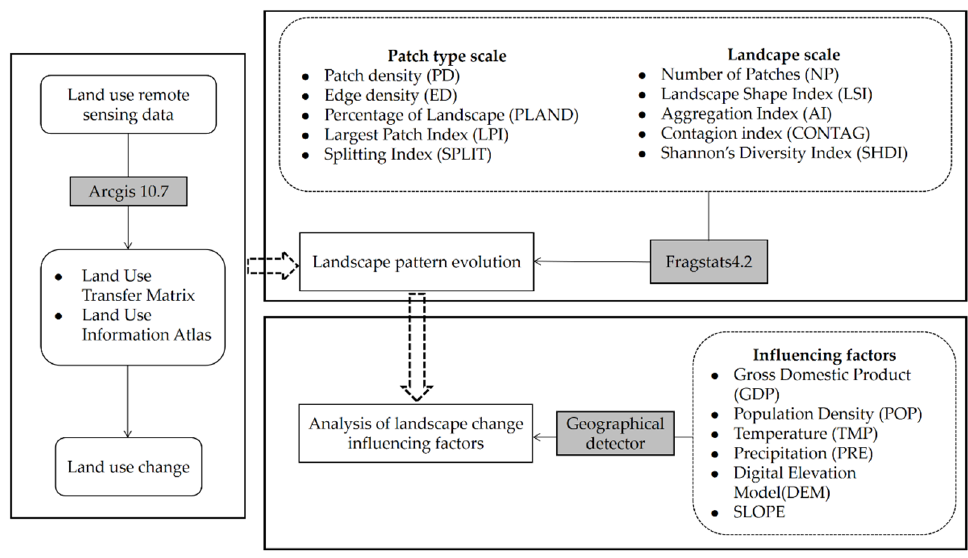
Figure 2. The workflow of this study.